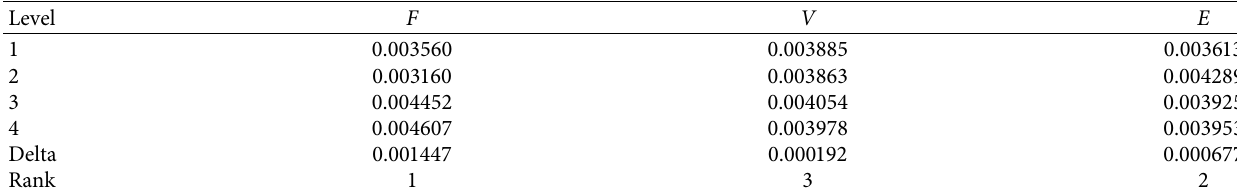
Table 6: Fits response.